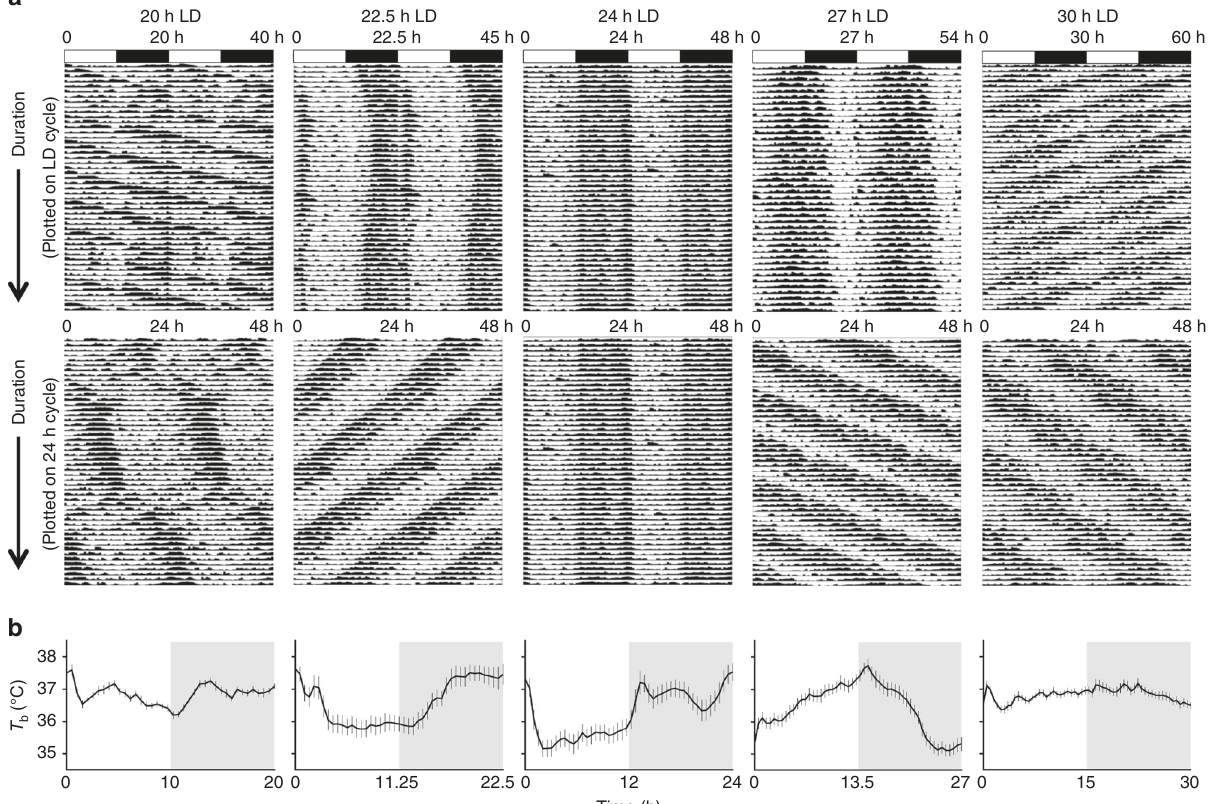
Fig. 1 Long-term housing under non-24h LD cycles drives phase desynchrony between physiological rhythms and the LD cycle. a Representative body temperature ( T b ) rhythms from mice maintained on 20, 22.5, 24, 27 and 30 h LD cycles. Top panels are double plotted relative to LD cycle time; bottom panels are plotted on 24 h frequency. b Group T fi les across the LD cycle (derived from 10 consecutive cycles, after 40 d LD exposure) highlight the b pro delayed (22.5 h) and advanced (27 h) phase of entrainment in non-24h LD housed mice. Data in b re fl ect mean ± SEM, n = 7/group for 20 and 30 h LD; n